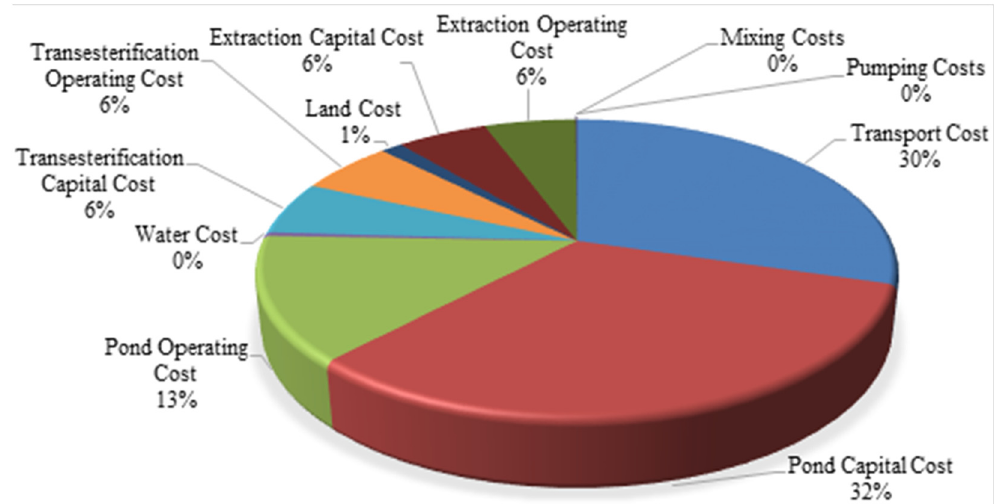
Figure 19. Cost associated with the United States biomass to biodiesel supply chain network problem when there is no transportation cost for the first layer.